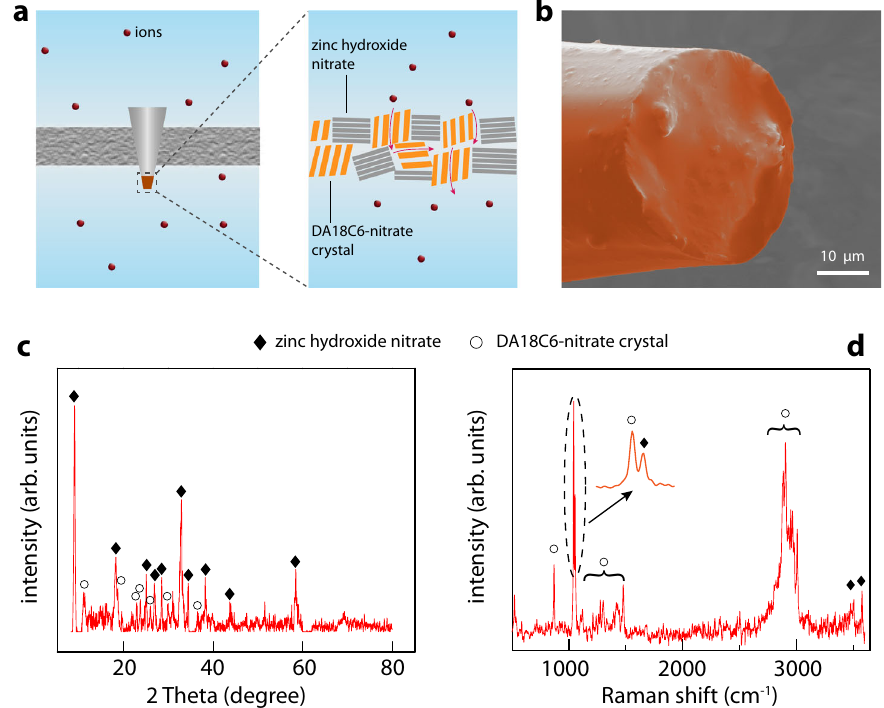
Fig. 2 Preparation of the arti fi cial sodium-selective ionic device. a The tip of a micropipette was fi lled with porous DA18C6-nitrate crystals which sieves ions, and nonporous zinc hydroxide nitrate which mechanically con fi nes the DA18C6-nitrate crystals. The micropipette was placed between two electrolyte reservoirs to measure the ion transport property. b Scanning electron microscope image of the fi lled micropipette tip. c X-ray diffraction pattern of the fi lling mixture. Major peaks can be assigned to either DA18C6-nitrate crystal or zinc hydroxide nitrate (see also Fig. 1f and Supplementary Fig. 5). d Raman spectrum of the mixture, whose peaks can also be assigned to either DA18C6-nitrate crystal or zinc hydroxide nitrate (see also Supplementary Figs. 3 and 6). These results con fi rm that the fi lling mixture is composed of DA18C6-nitrate crystals and zinc hydroxide